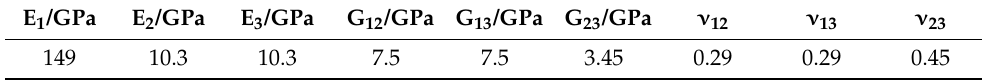
Table 1. Elastic properties of the T800S/3900-2B lamina.